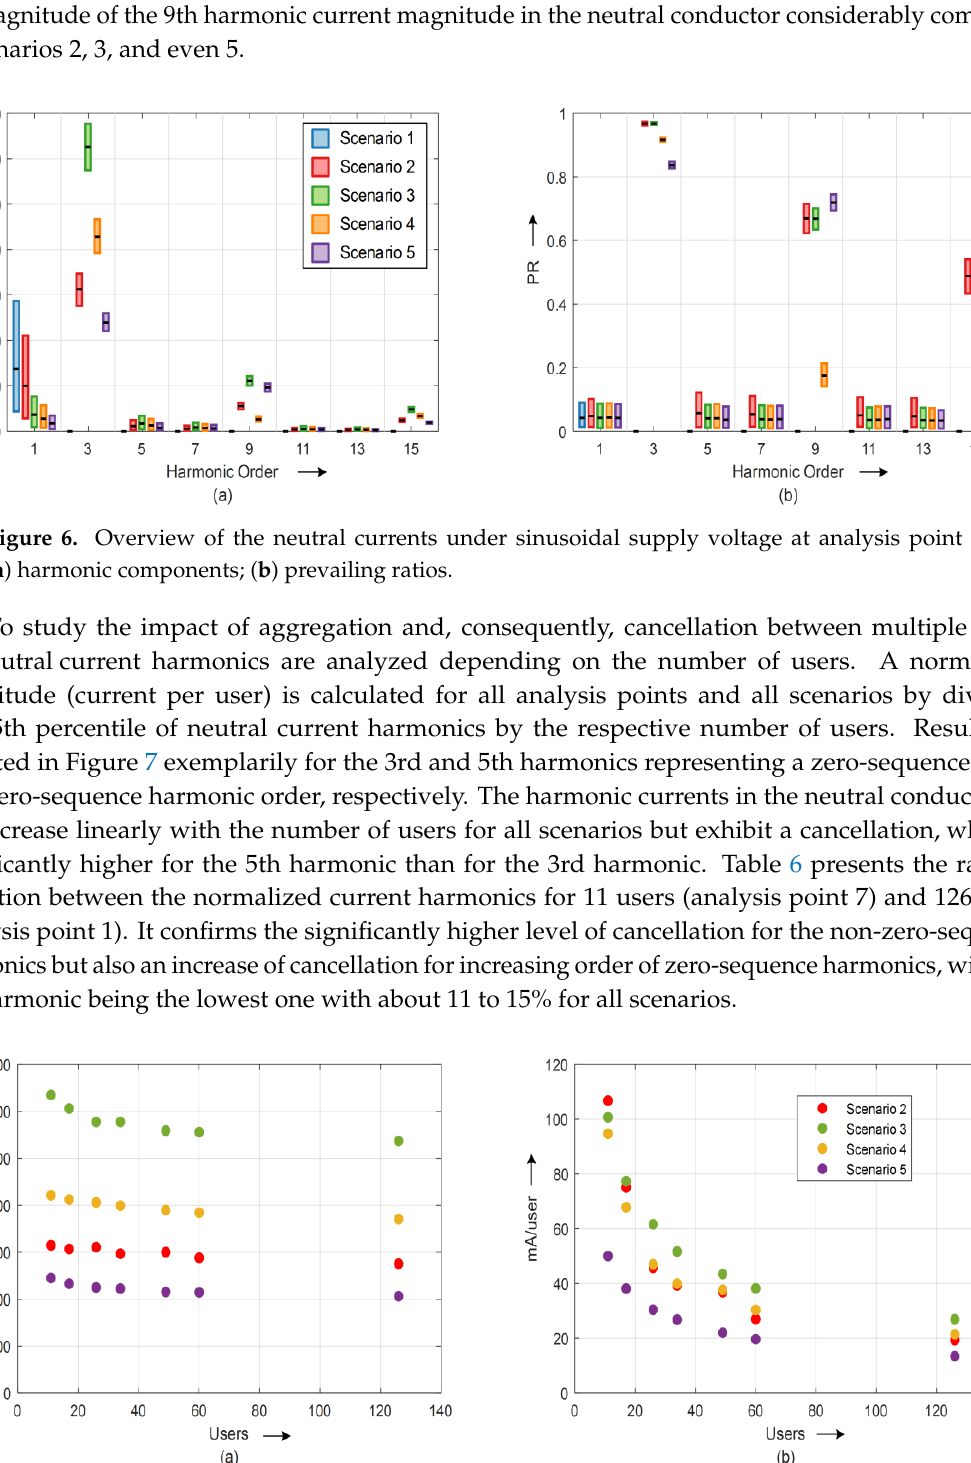
Figure 5. Neutral current RMS values for all scenarios under sinusoidal supply voltage.